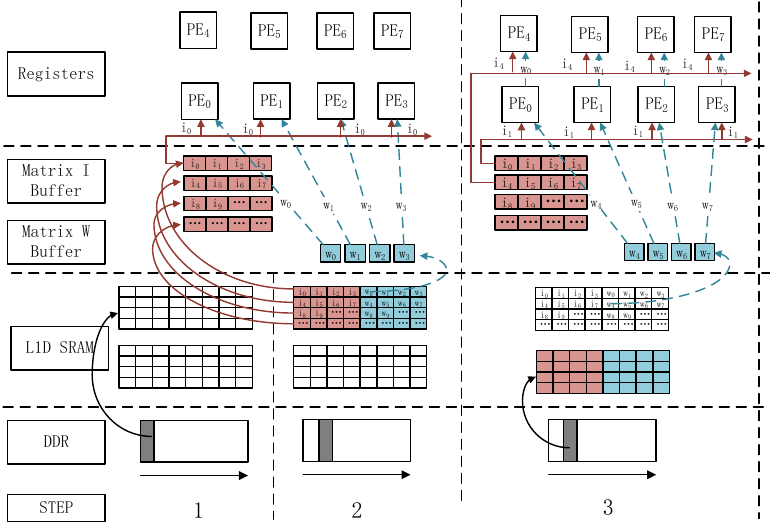
Figure 12. The double buffer data moving strategy based on DMA.